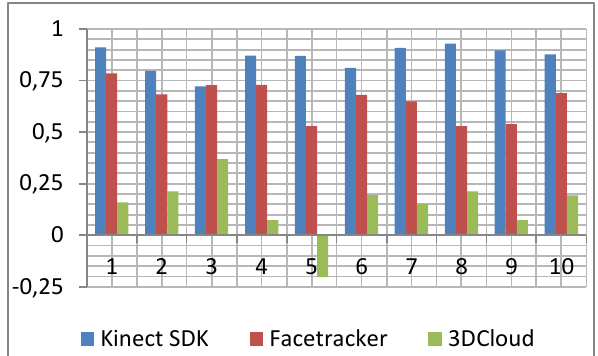
Figure 23. Mean correlation for the pitch for each candidate.